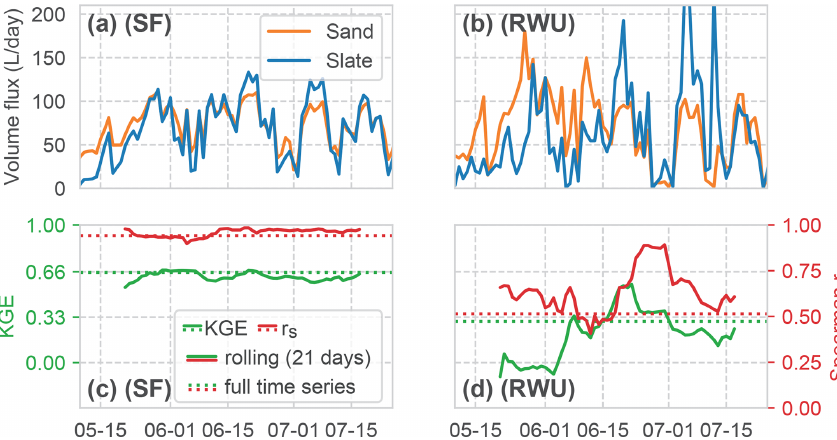
Figure 10. Comparison of the time series of the calculated volume fluxes for RWU and SF between both sites (panels (a) and (b) for SF and RWU, respectively). Correlation of the RWU and SF fluxes between the sites, both as KGE and r s . Signatures are similar to Fig.